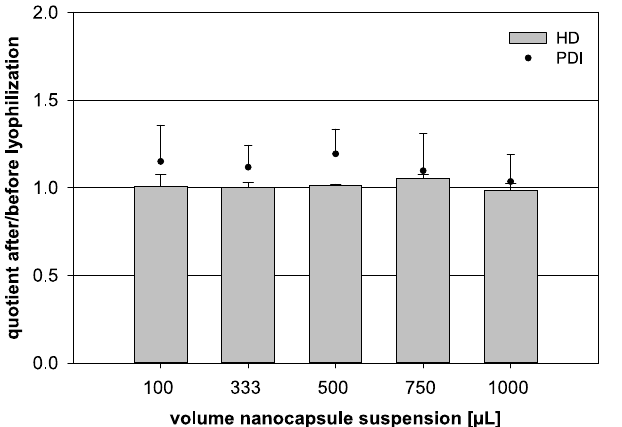
Figure 5. Influence of the lyophilization on the quotient of the hydrodynamic diameter (HD, bars) and the quotient of the polydispersity index (PDI, dots) before and after lyophilization, respectively. Different volumes of nanocapsule suspension were combined with a fixed trehalose content of 6% ( w / v ) (statistical test: one-way ANOVA; no significance between the compared groups regarding the HD quotient; p = 0.326; mean ± SD; n = 3).